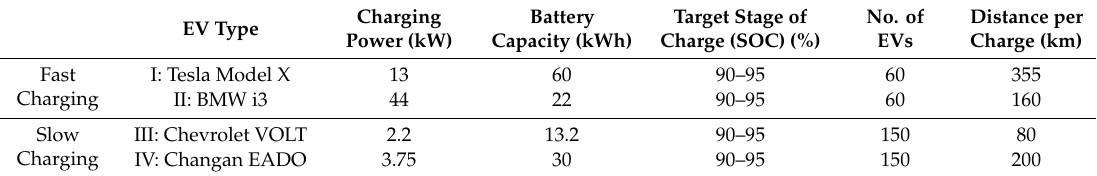
Table 1. Simulation parameters for EV type and EV charging infrastructure.